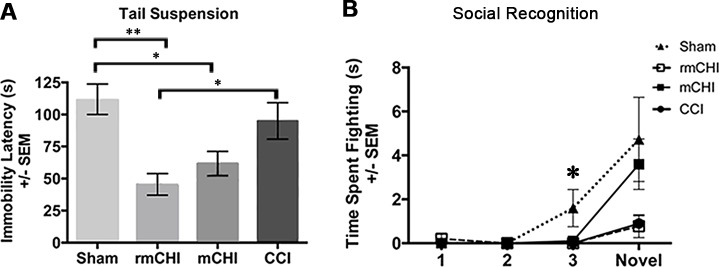
Tests of affective behavior at 90 dpi suggest that TBI induces depression and increased passivity towards other mice.(A) Depression-like behaviors were tested using the tail suspension test, in which both mCHI and rmCHI animals gave up (became immobile) more quickly than shams (**p<0.01 and *p<0.05, respectively), and rmCHI mice gave up more quickly than CCI animals (*p<0.05). Interestingly, CCI mice were not different than shams. (B) When aggressive behavior was assessed in a social recognition test, sham, but not injured, mice engaged in more fighting with the stimulus mouse by trial 3 (*p<0.05). rmCHI and CCI, but not mCHI, mice were more passive than shams when a new mouse was introduced on the 4th (novel) trial, although not significantly.